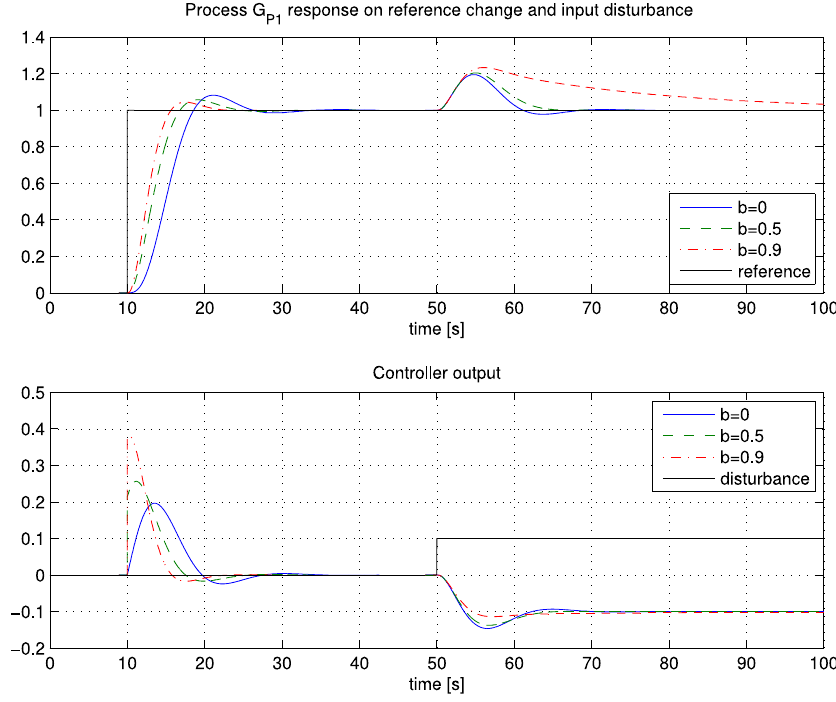
Appl. Sci. 2020 , 10 , x Figure 8. G P 1 process closed-loop experiment. Figure 8. G P 1 process closed-loop experiment.